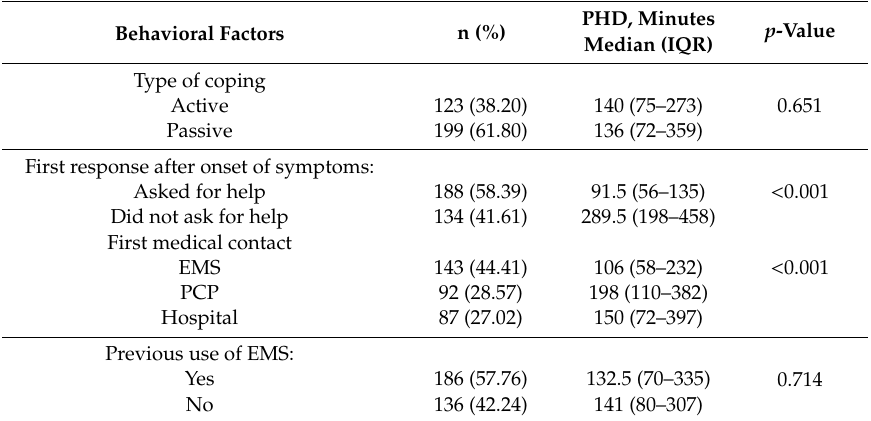
Table 3. Time from symptom onset to the hospital arrival by behavioral factors.